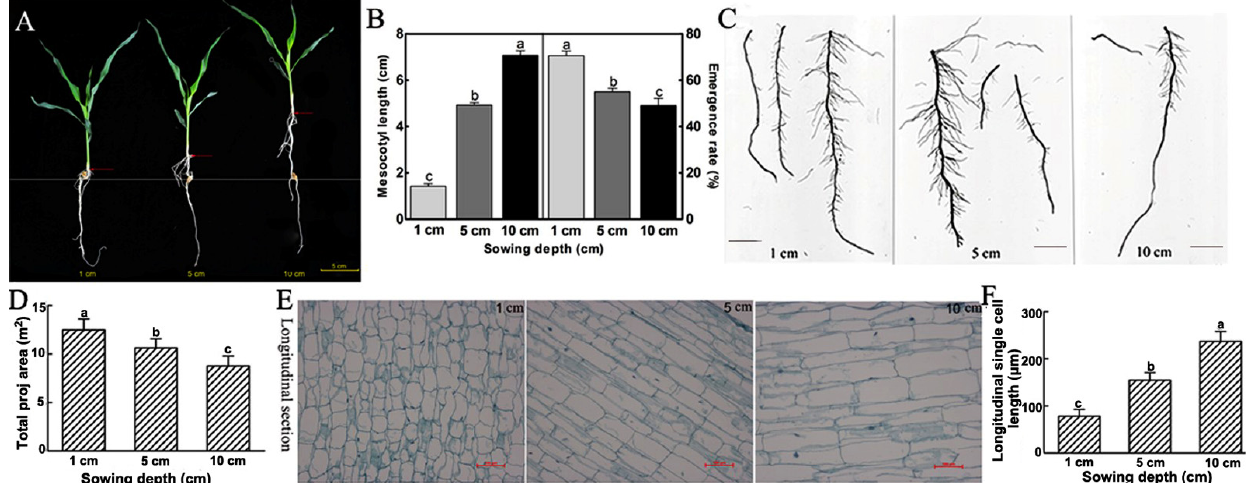
Figure 1. Differences of mesocotyl and root system of sweet maize inbred line Ltx05 under different sowing depth of 1, 5 and 10 cm cultivated for 15 days. The values are means ± SD of three replicates. Difference letters indicate significance using one-way ANOVA ( p < 0.05). ( A ) The seedling pheno- type and bar = 5 cm; ( B ) the mesocotyl length and emergence rate; ( C ) root system scanning and bar = 2 cm; ( D ) the root surface area; ( E ) longitudinal structure of mesocotyls; and ( F ) longitudinal single cell length.